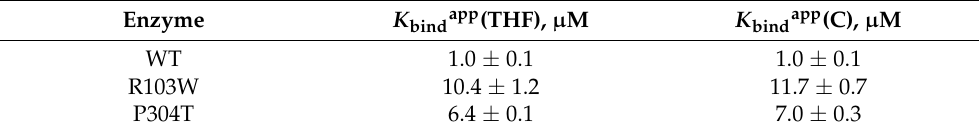
Table 3. Affinity of hNEIL2 for bubble